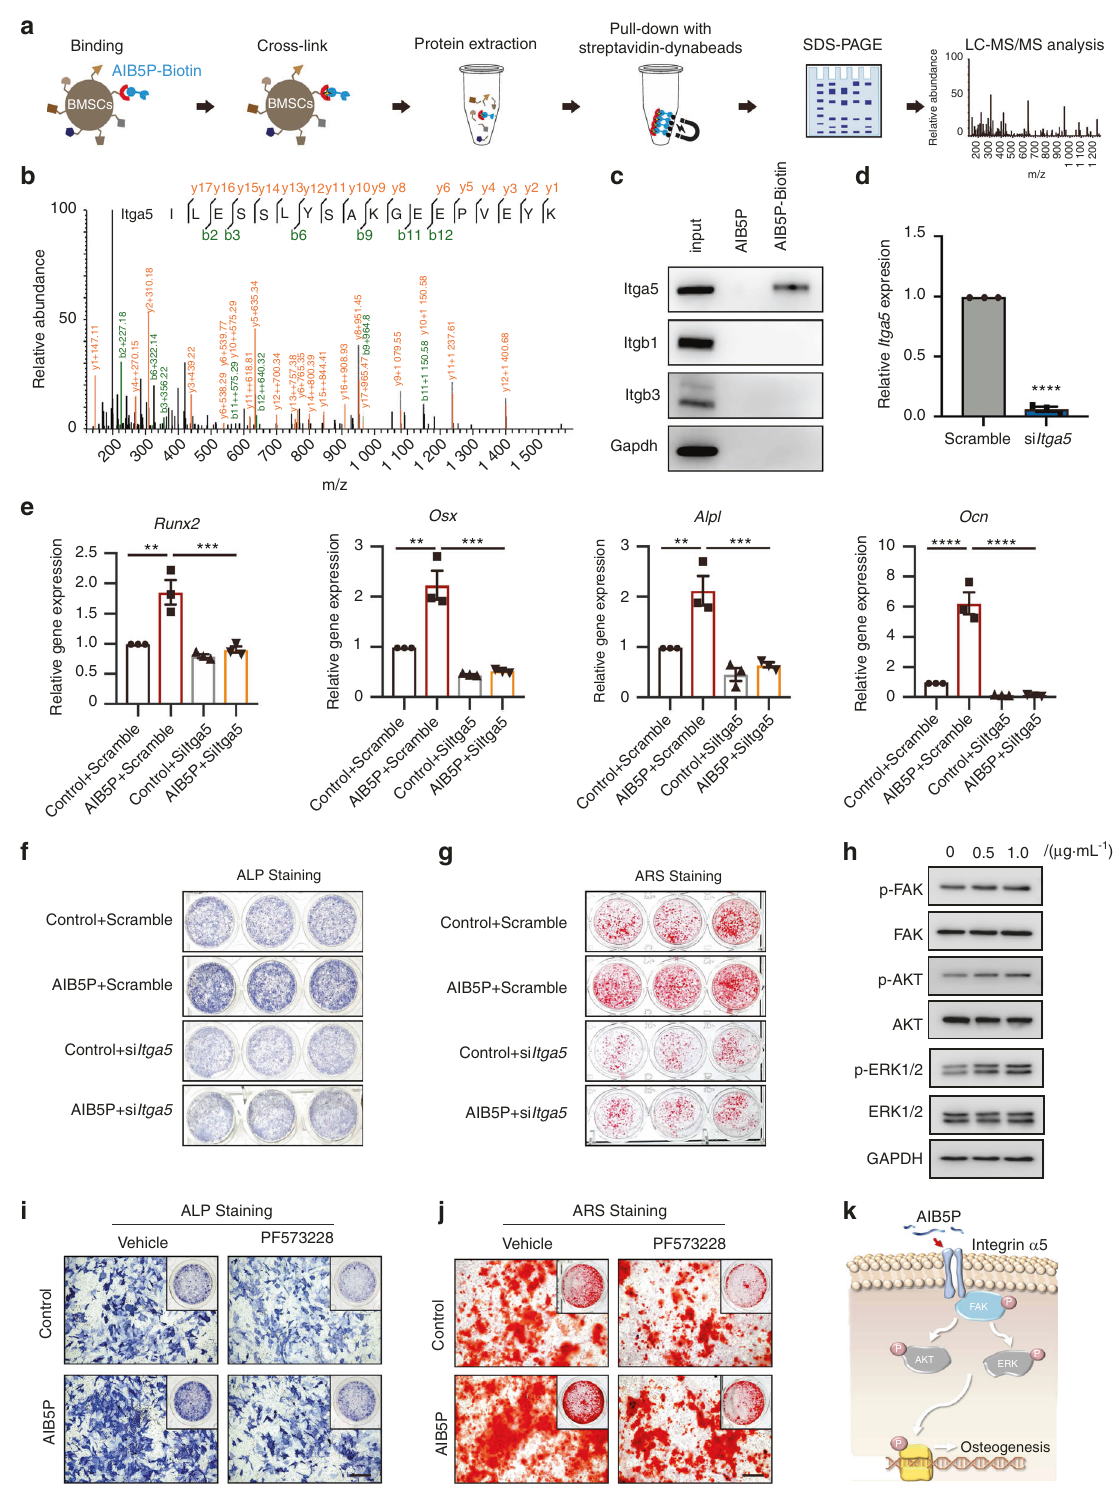
Fig. 6 AIB5P interacts with integrin α 5 to promote osteogenesis. a Schematic diagram of the biotinylated peptide pulldown/MS assay. b Mass spectrometry analysis identi fi ed Itga5, which was pulled down from BMSC lysates by biotin-labeled AIB5P. c Representative western blots of Itga5 pulled down by biotin-labeled AIB5P. d qPCR analysis of siRNA-mediated Itga5 gene silencing ef fi ciency. n = 3 e qPCR analysis of known osteogenic markers in AIB5P-treated, Itga5 knockdown BMSCs. n = 3 f ALP staining and g ARS staining of AIB5P-treated, Itga5 knockdown BMSCs. The experiment was repeated three times independently with similar results. h Representative western blots of FAK signaling component proteins in AIB5P-treated BMSCs. The experiment was repeated three times independently with similar results. i ALP staining and j ARS staining of AIB5P-treated BMSCs in the presence of the Itga5 inhibitor PF573228 (10 μ mol·L − 1 ). The experiment was repeated three times independently with similar results. Bar, 100 μ m. k Schematic diagram of AIB5P-related osteogenic